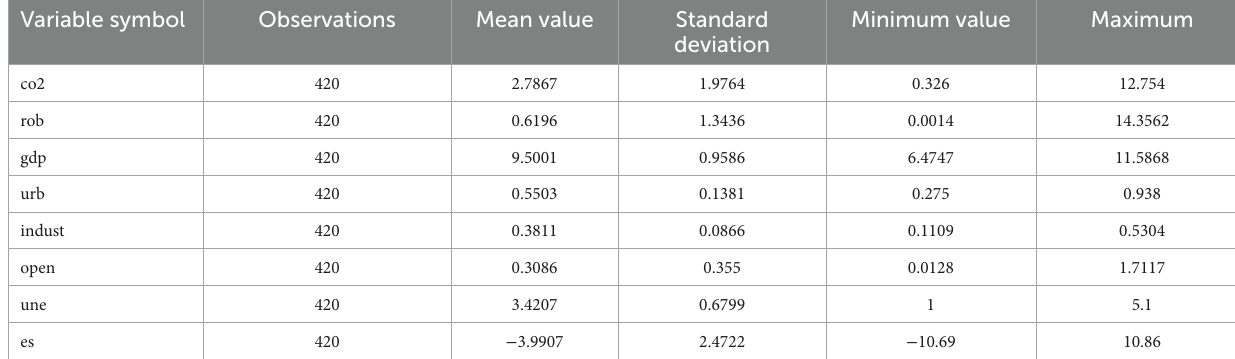
TABLE 1 Descriptive statistics of variables. Variable symbol